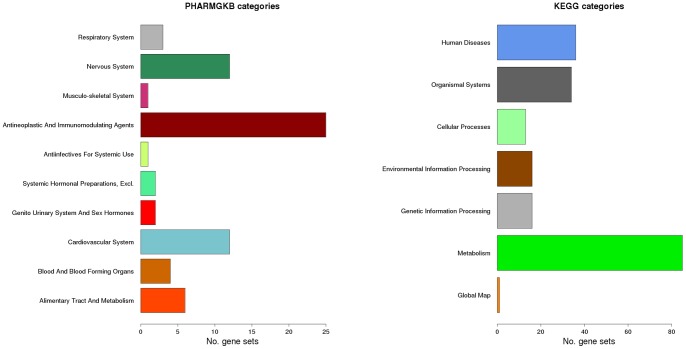
Barplots for number of GSs in PharmGKB and KEGG categories.